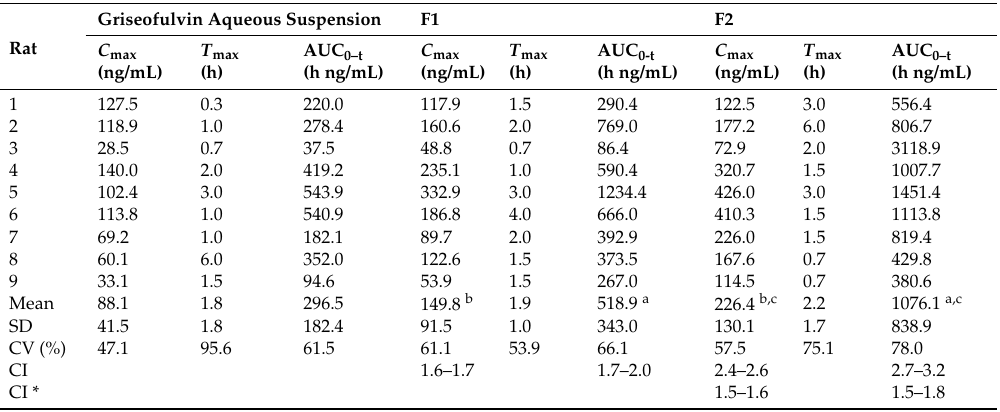
Table 5. Individual values of C max , T max , AUC 0–t and 90% confidence interval for griseofulvin after oral administration of griseofulvin aqueous suspension, F1 and F2.